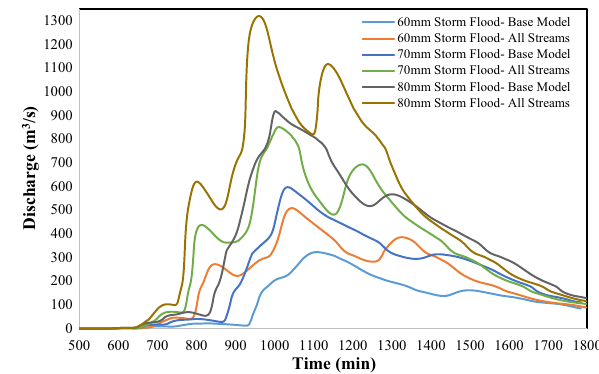
Fig. 16 Flood hydrographs of calibrated GSSHA base model for two 24 h floods of 65 and 75 mm cumulative depths compared to hydro- graphs corresponding to GSSHA model by modeling all watercourses with a drainage area of larger than 5 km 2